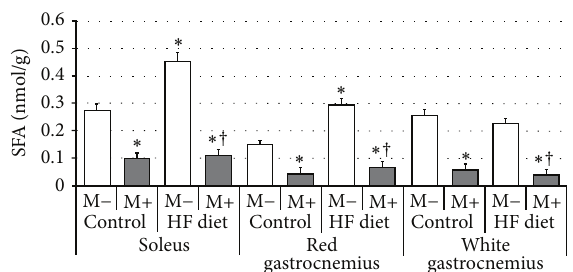
Figure 1: Effect of high-fat diet (HFD) feeding (5 weeks) and/or myriocin application (7 days) on sphinganine (SFA) content in skeletal muscles ( 𝑛 (per group) = 8). M+: rats administered with myriocin. M − : untreated group. Results are expressed as means ± SD. ∗ 𝑝 < 0.05 compared with control group. † 𝑝 < 0.05 compared with HF diet group.